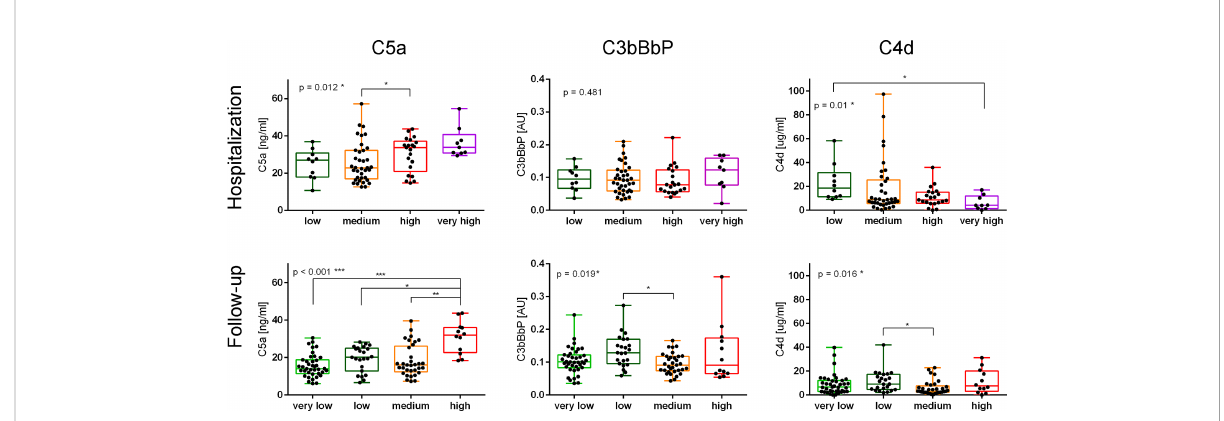
FIGURE 1 Markers of complement activation in samples collected from patients with different severities of COVID-19 during hospitalization and follow-up. Serum samples collected from COVID-19 patients during the hospitalization and follow-up were divided into groups based on the disease severity. Patients classi fi ed as “ very low ” severity did not need hospitalization, and therefore only follow-up samples were available. Conversely, patients classi fi ed to the “ very high ” severity group died during the hospitalization. The other severity groups were set up according to the number of days up to the hospital discharge: ≤ 7 for a low-severity group, 8 – 13 days for a medium-severity group, and ≥ 14 for a high-severity group. The results of the C5a measurement were originally published in ref. 4; herein, we present the data obtained for each severity group during hospitalization and follow-up. Symbols *, **, and *** indicate p values <0.05, <0.01, and <0.001, respectively, according to the Kruskal – Wallis test with Dunn ’ s multiple-comparison